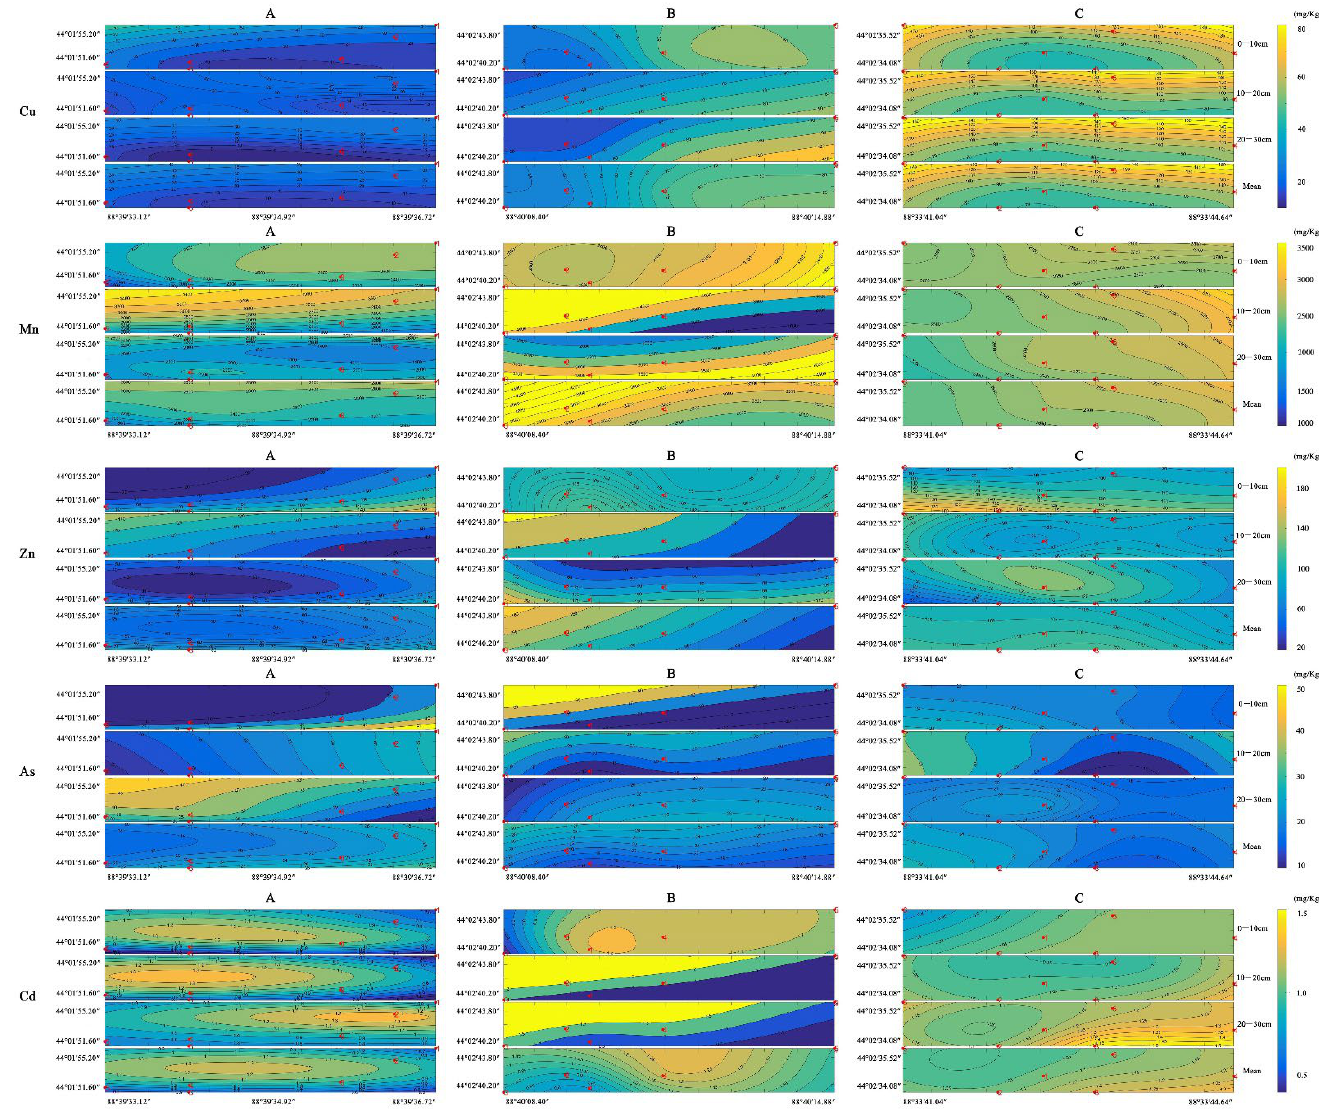
Figure 4. Spatial distribution of the heavy metal content in the soil.